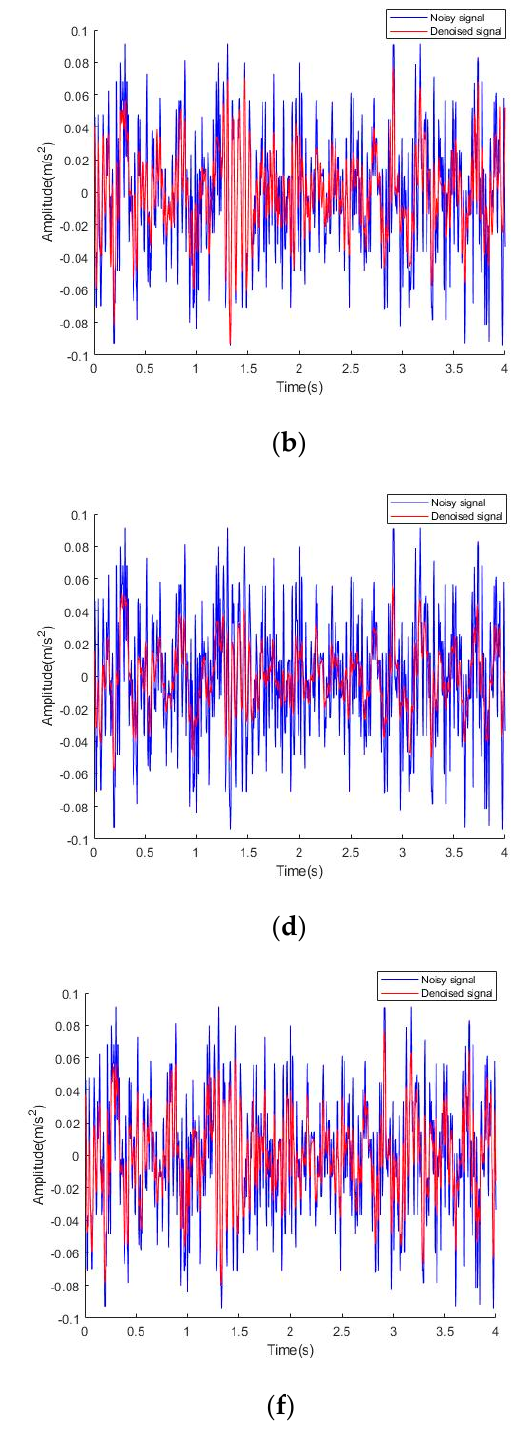
Figure 8. Time domain diagram of x -axis signal before and after denoising: ( a ) EMD denoising method; ( b ) EEMD denoising method; ( c ) CEEMD denoising method; ( d ) bilateral filtering denoising method; ( e ) VMD denoising method; ( f ) CEEMD-BF denoising method.